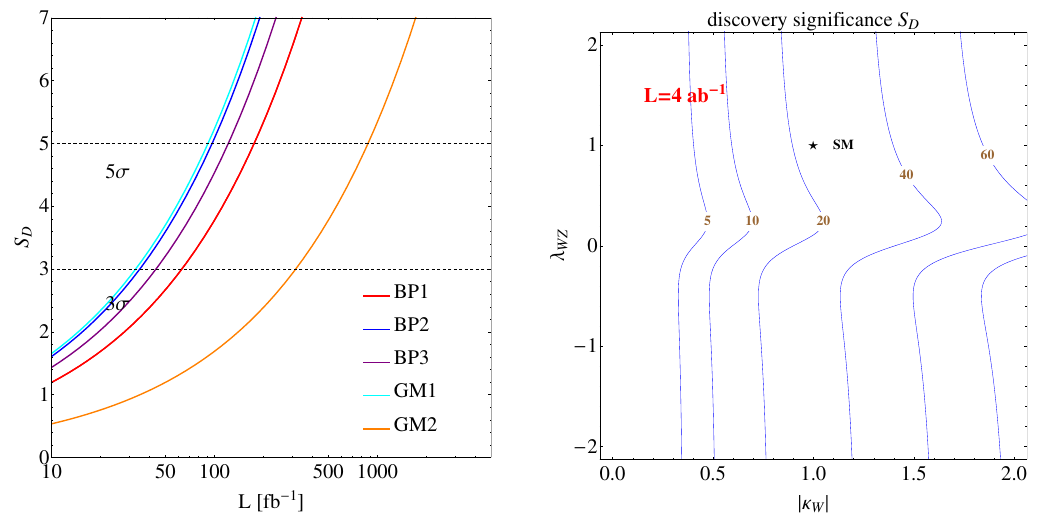
Figure 9 . Discovery potential of e + e (cid:0) W + W (cid:0) H in the ‘ (cid:6) ‘ (cid:6) ‘ (cid:7) jj channel for scheme B at the ! 500-GeV ILC with the beam polarization P ( e (cid:0) ; e + ) = ( 0 : 8 ; +0 : 3). Left: signal signi(cid:12)cance of the (cid:0) (cid:12)ve scenarios (de(cid:12)ned in the main text) as a function of the integrated luminosity. Right: contours (cid:20) W of signal signi(cid:12)cance in the - (cid:21) WZ plane, assuming an integrated luminosity of 4 ab (cid:0) 1 . j j